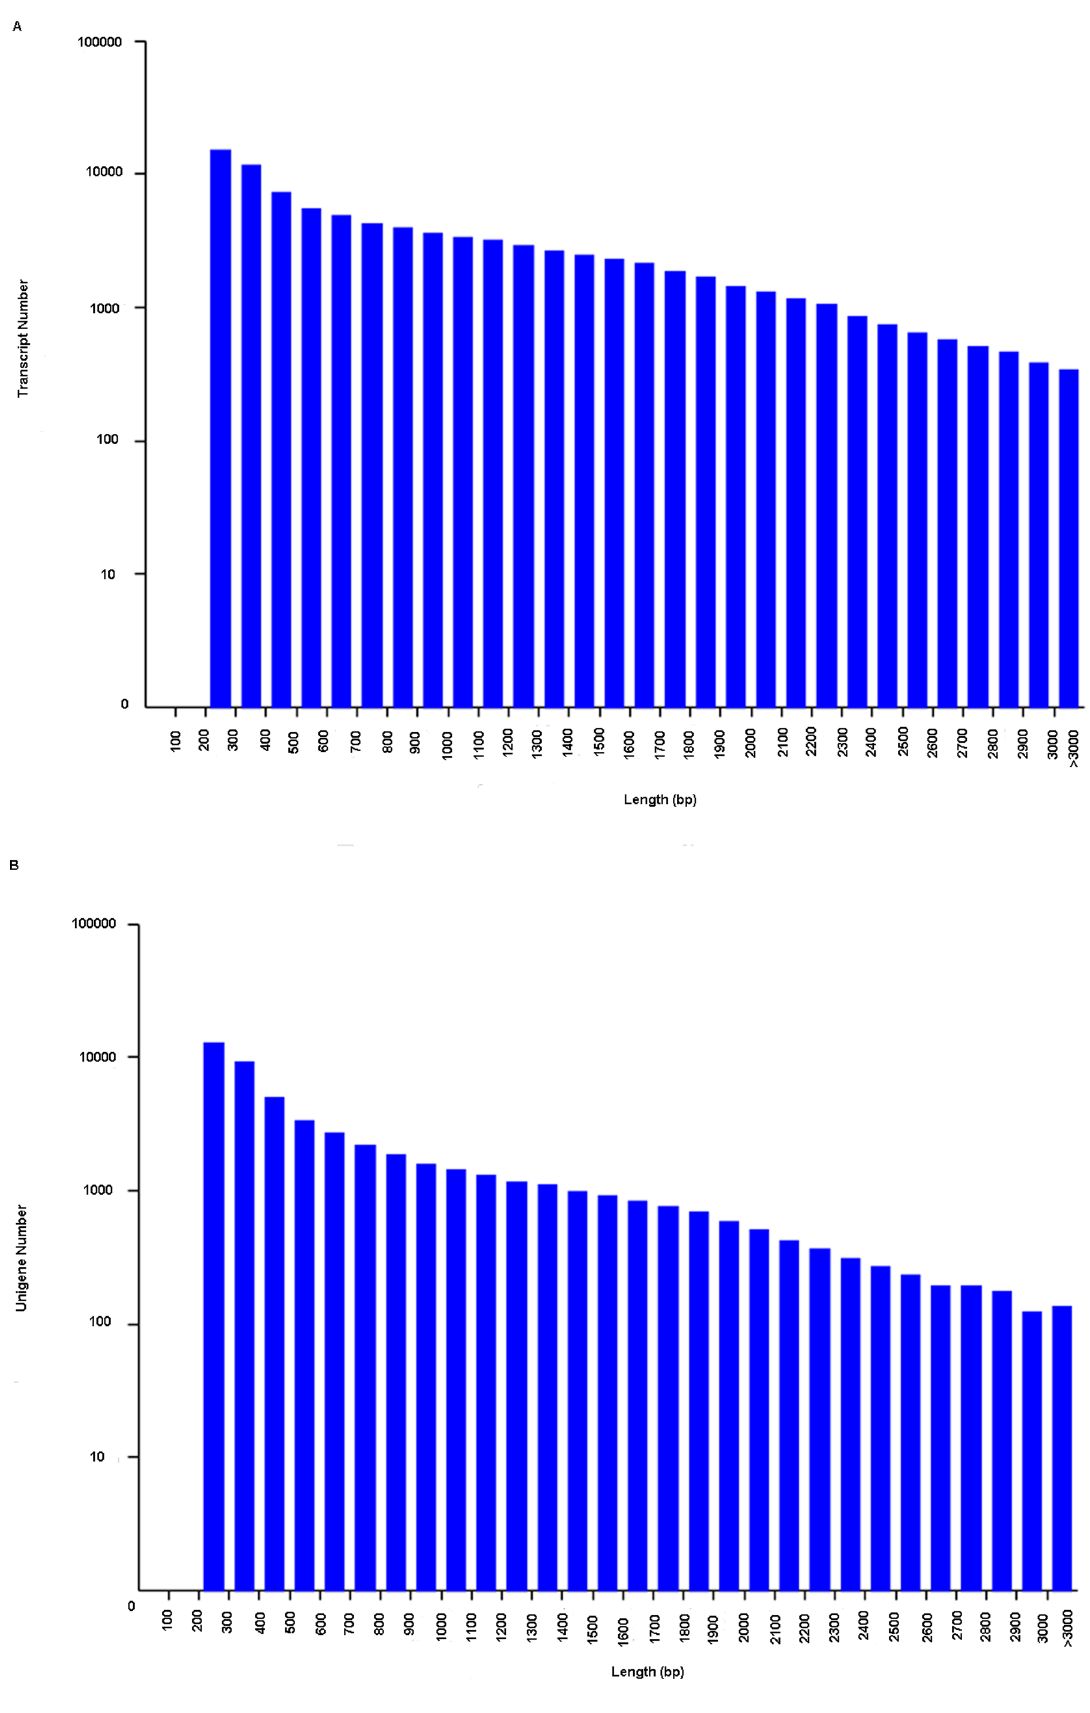
Figure 1. Overview of the Youngiajaponica transcriptome assembly. (A) Size distribution of contigs; (B) size distribution of unigenes. doi:10.1371/journal.pone.0090636.g001 PLOS ONE |